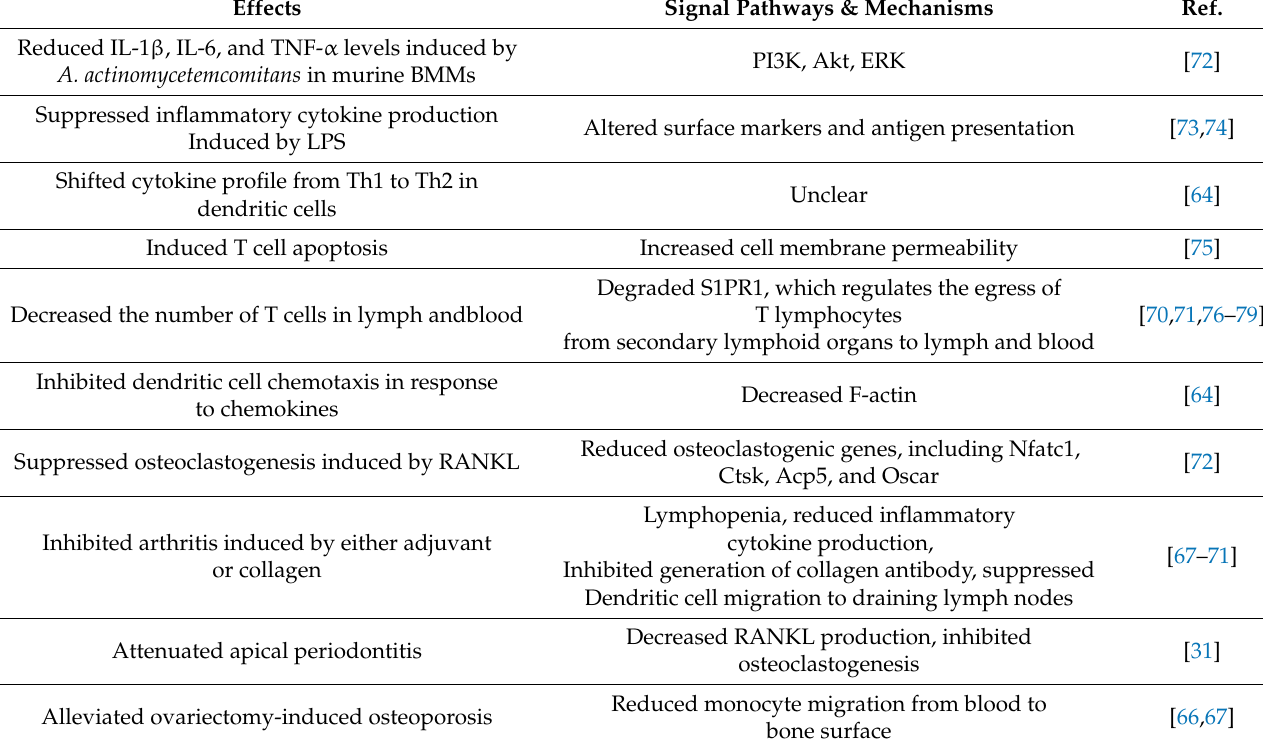
Table 2. Biological effects of FTY720 in regulating inflammatory bone loss